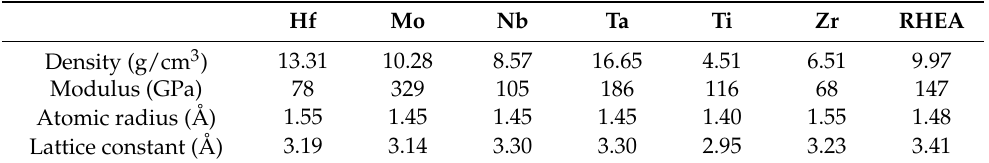
Table 1. Basic Properties of The Constituent Metallic Elements of RHEA [33–40] and The Average Properties of RHEA by The Rule of Mixture.